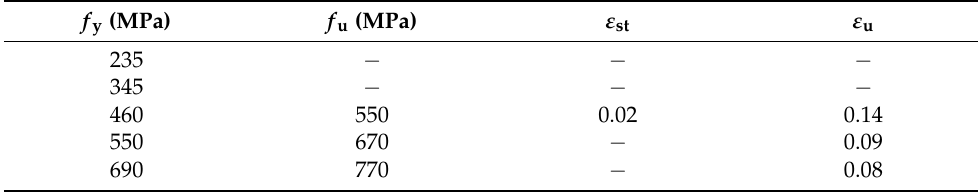
Table 2. Specific parameters for constitutive models of